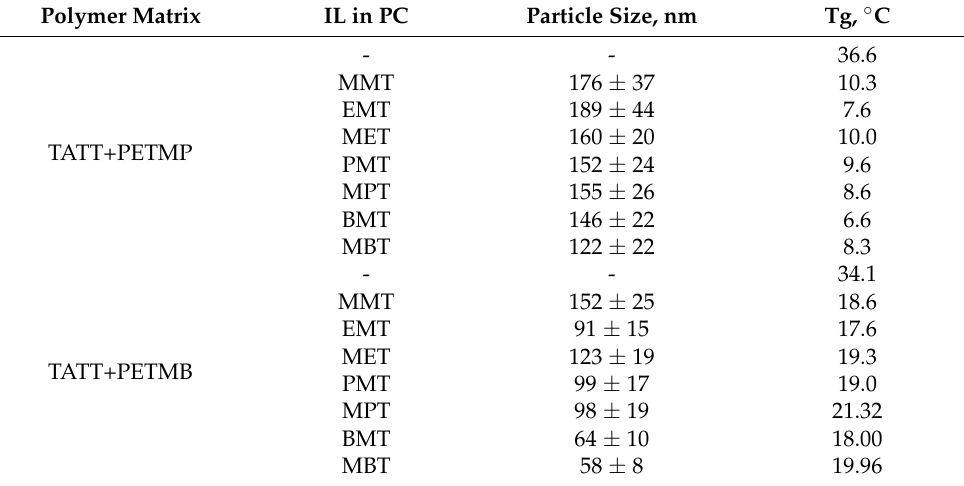
Table 4. Size of the polymer particle of the polymer matrix of ionogels (determined from SEM micrographs) and the glass temperature transition Tg of the